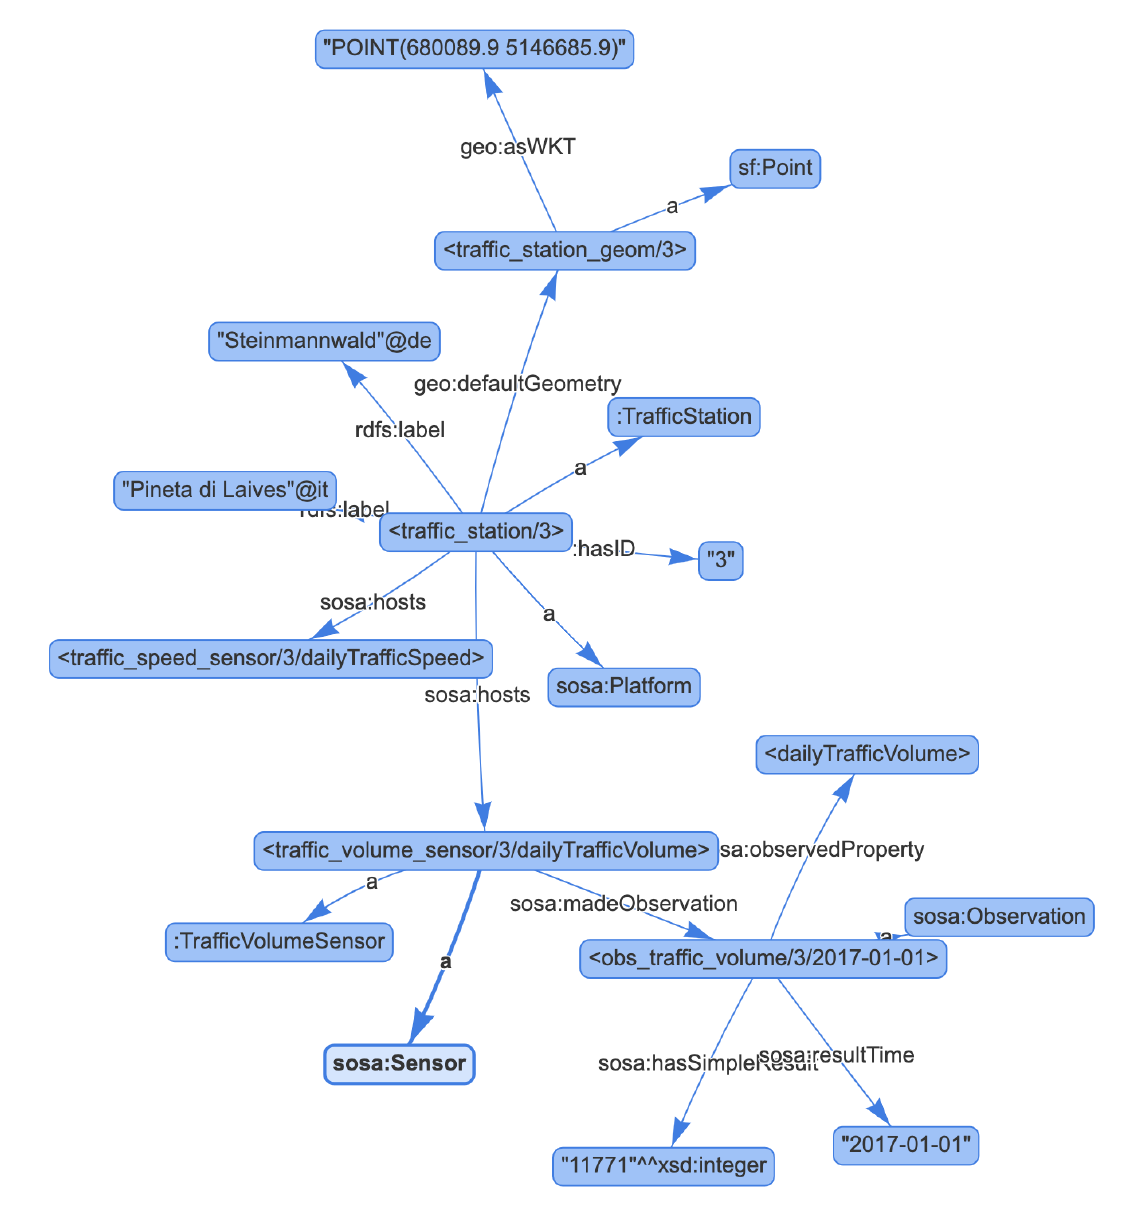
Figure 5. Example triples generated by the mapping